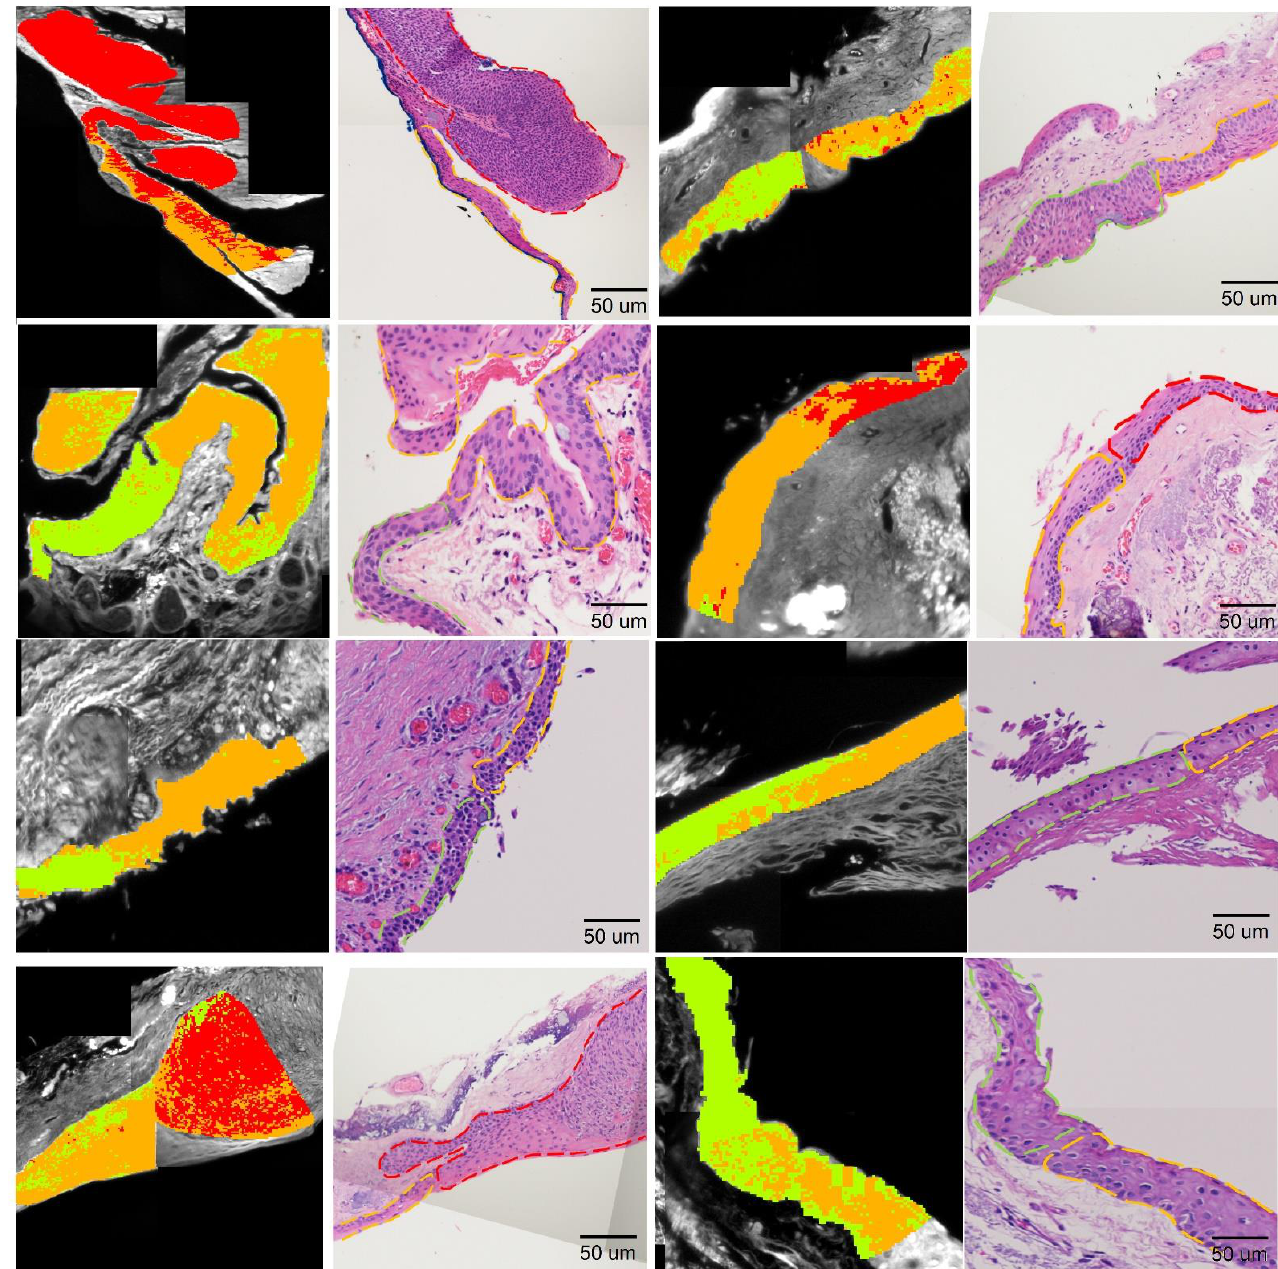
Figure 6. False color map generated to locate the normal, PTG, and OSSN boundary on the testing section based on intra-patient classification framework compared to the associated histology images. The block data position on a single spectral channel (Chno = 10) image is colored in red/orange/green if they are predicted to be OSSN/PTG/normal. First/third column is the multispectral false-color map. Second/forth column is corresponding H&E section with red, orange, and green dash lines highlighting OSSN, PTG, and normal section. fourth column), where H&E images were segmented with dash lines based on pathologist recommendation (Green dash line: normal section, red dash line: OSSN and orange dash line: PTG). Figure 6 shows a close correlation between the multispectral estimation and histopathological assessment at the interface for all of the eight intersections used in this